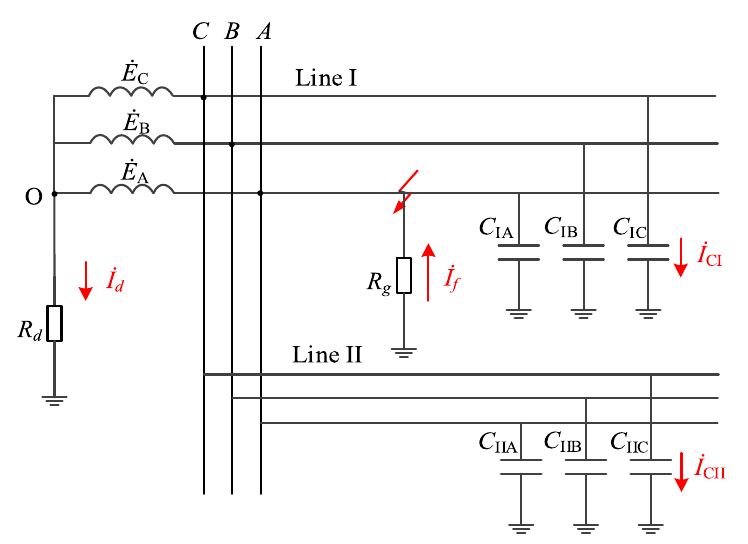
Fig. 4 HIF in low-resistance grounding